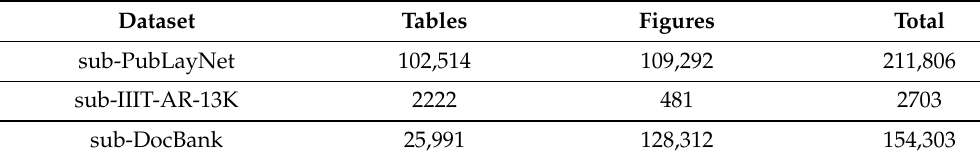
Table 4. The table represents the distribution of the Table and Figure annotations in the three subset training